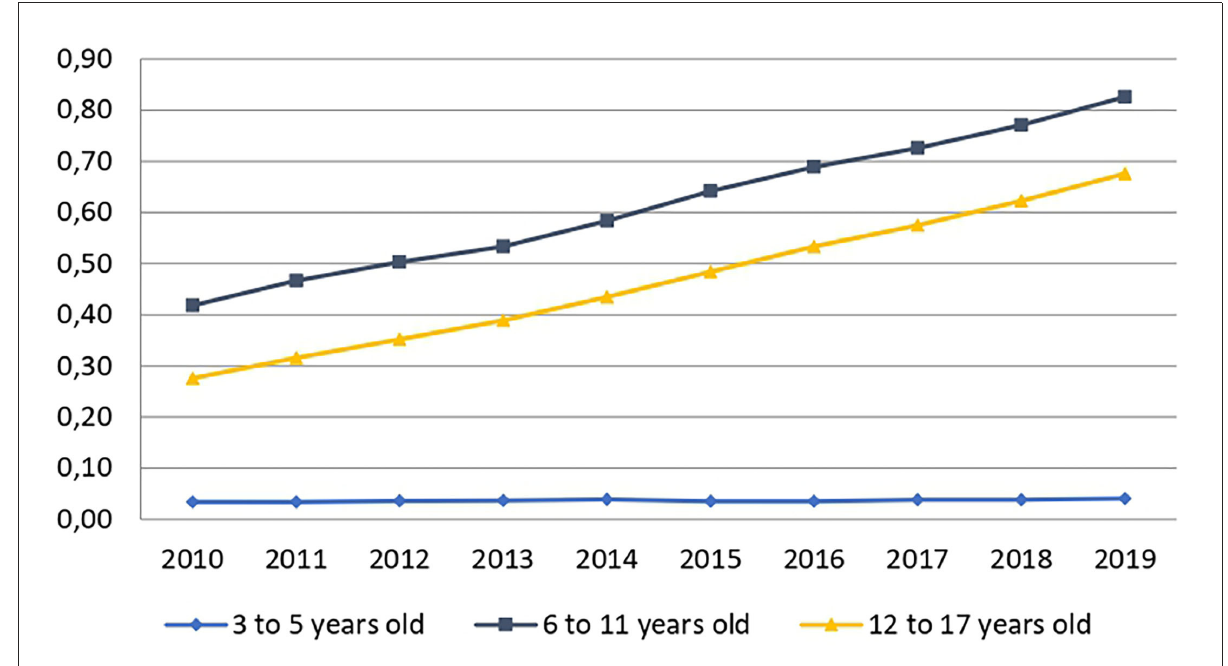
FIGURE2 Changes in the prevalence rate of MPH prescription. This rate is expressed as a percentage of the general population for each age-group and time